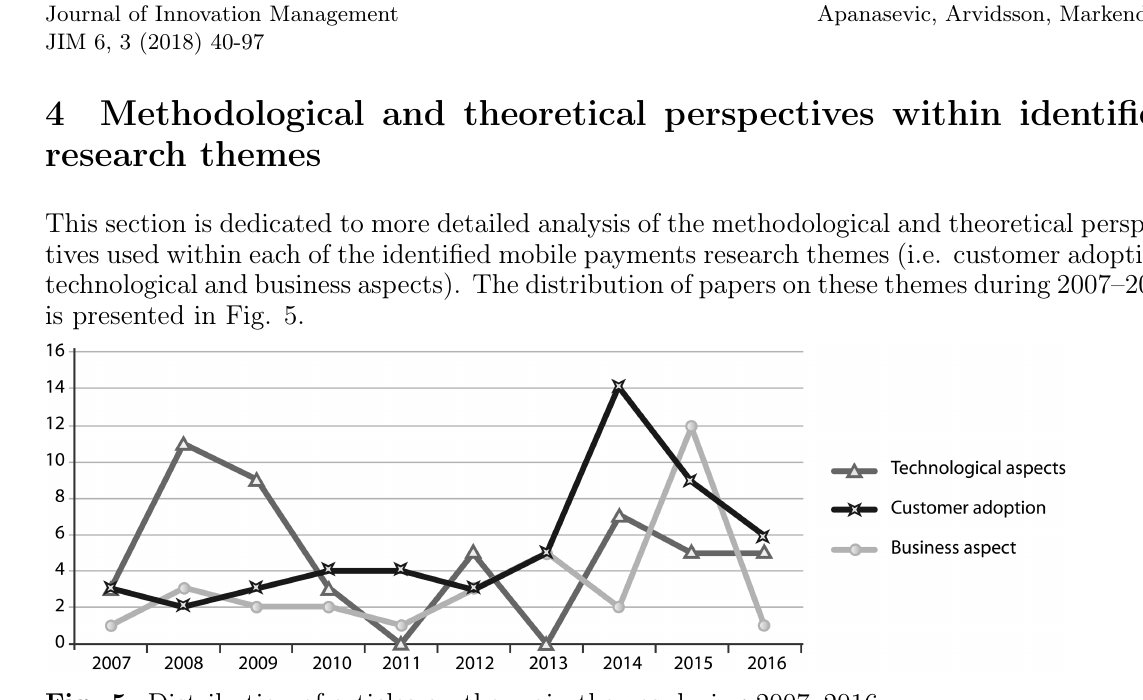
Fig. 5. Distribution of articles on the main themes during 2007–2016.